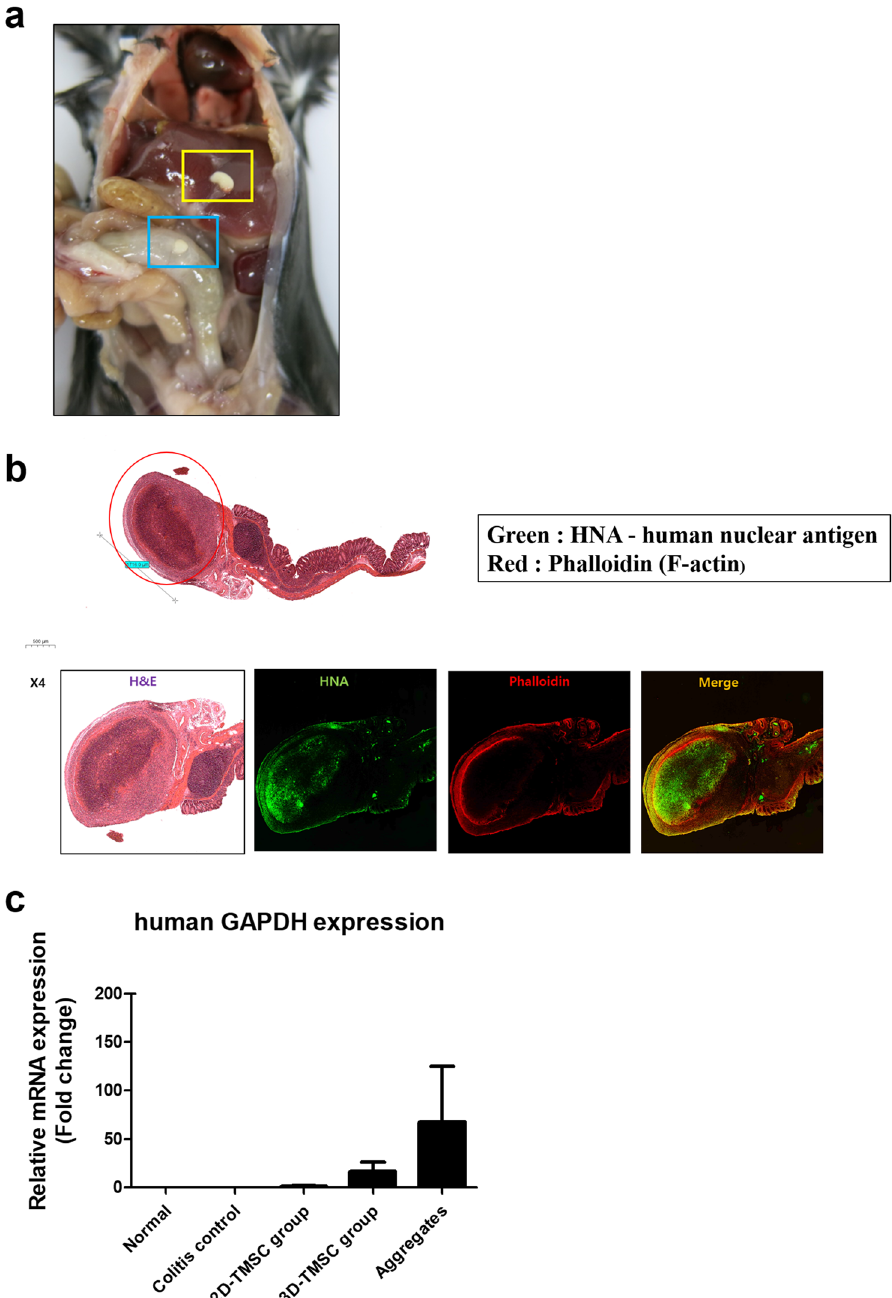
Figure 9. Localization of 3D-cultured TMSCs in the peritoneum of mice analyzed using immunofluorescence staining. ( a ) Image of the gross morphology of aggregates in the peritoneum of the mouse. ( b ) One aggregate was adjacent to the mouse colon. Fluorescence microscopy revealed that the previously observed aggregate was stained with green-colored anti-human nuclear antigen antibody. ( c ) The levels of human DNA in the peritoneal lavage fluid of each groups and aggregates. 3D, three-dimensional; TMSCs, tonsil-derived mesenchymal stem cells; H&E, hematoxylin–eosin; HNA, human nuclear